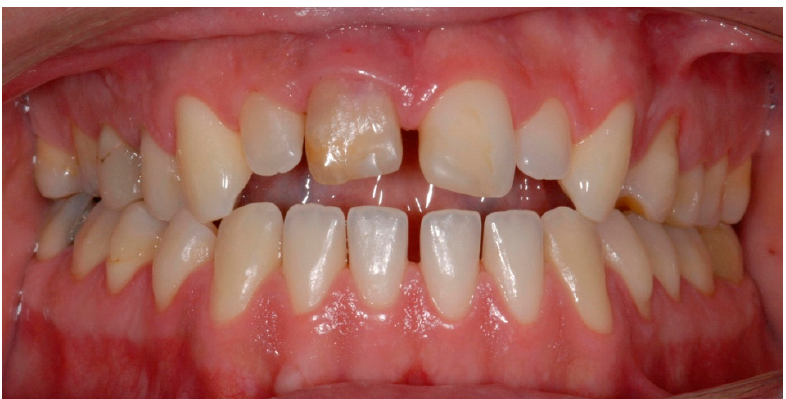
Figure 11. Intraoral view 16 years after delayed replantation of tooth 11.